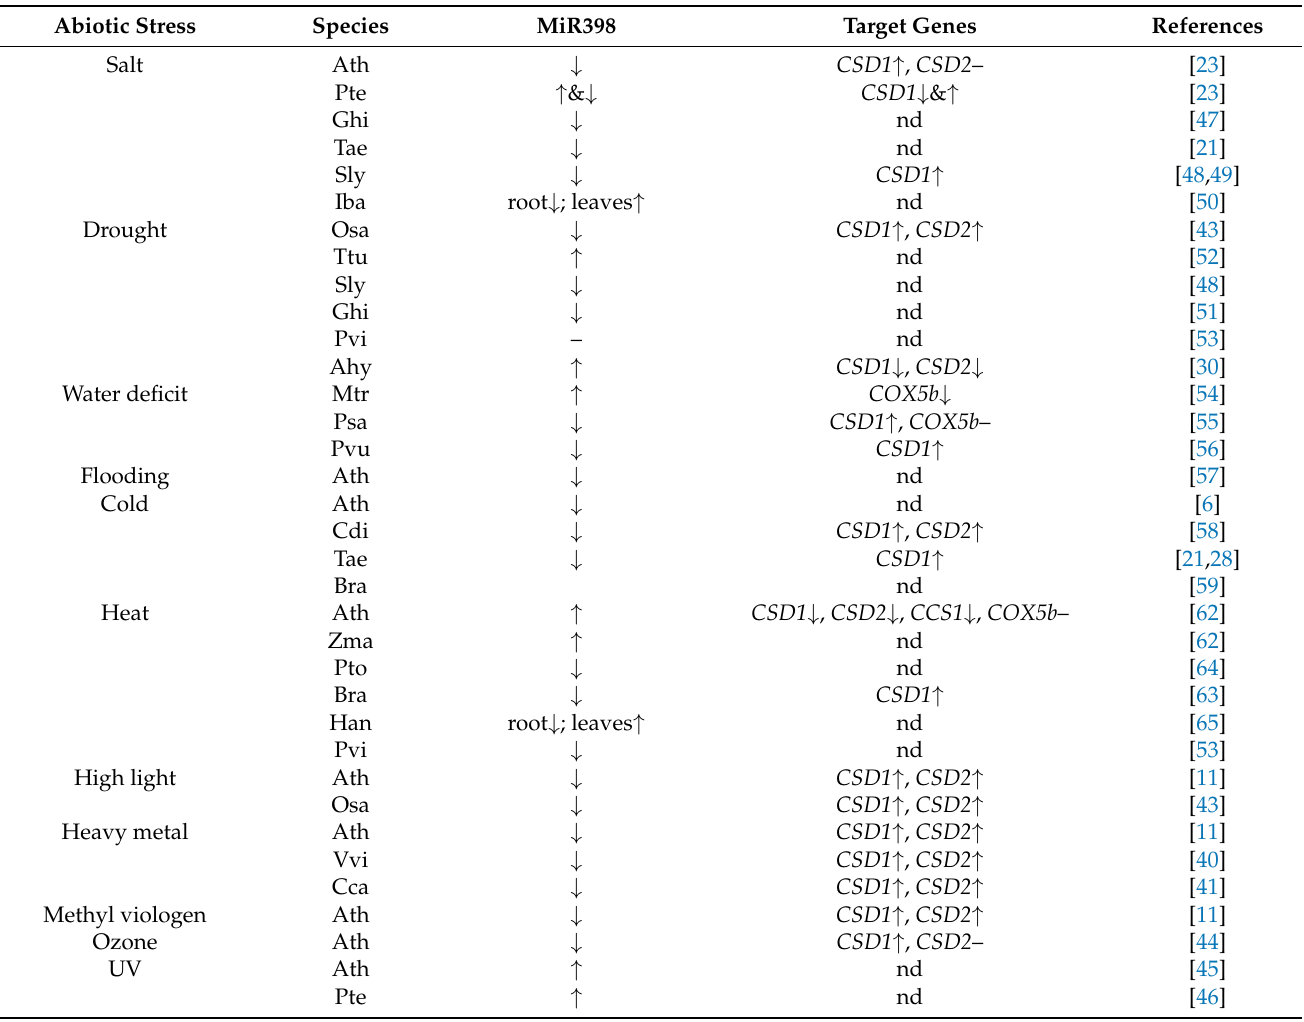
Table 1. MiR398 responses to abiotic stresses in diverse plant